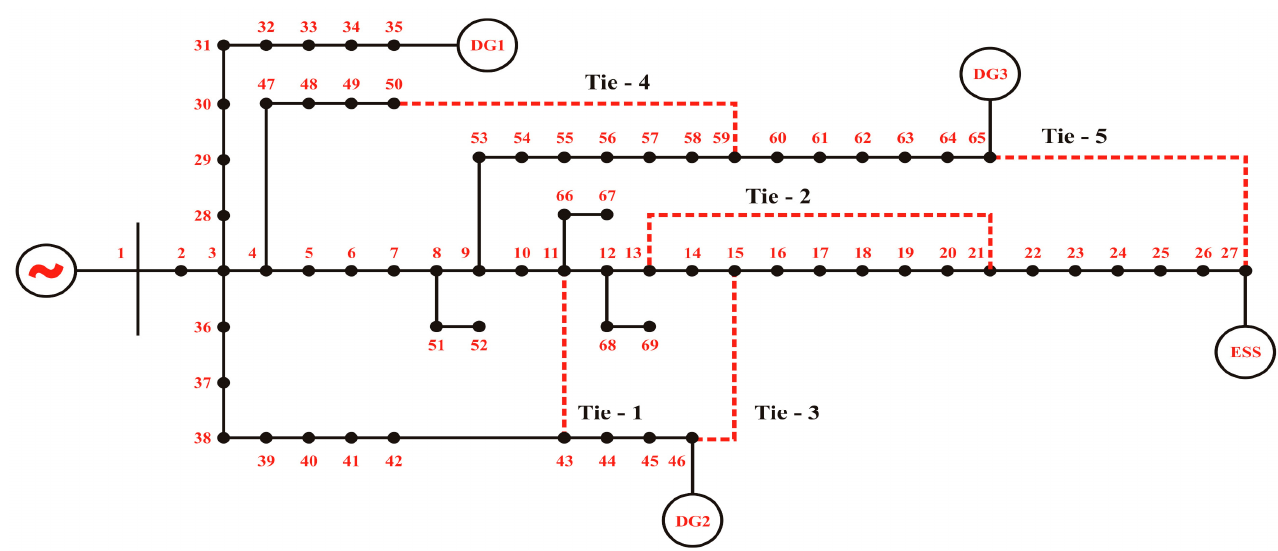
Figure 6. IEEE 69-bus system.